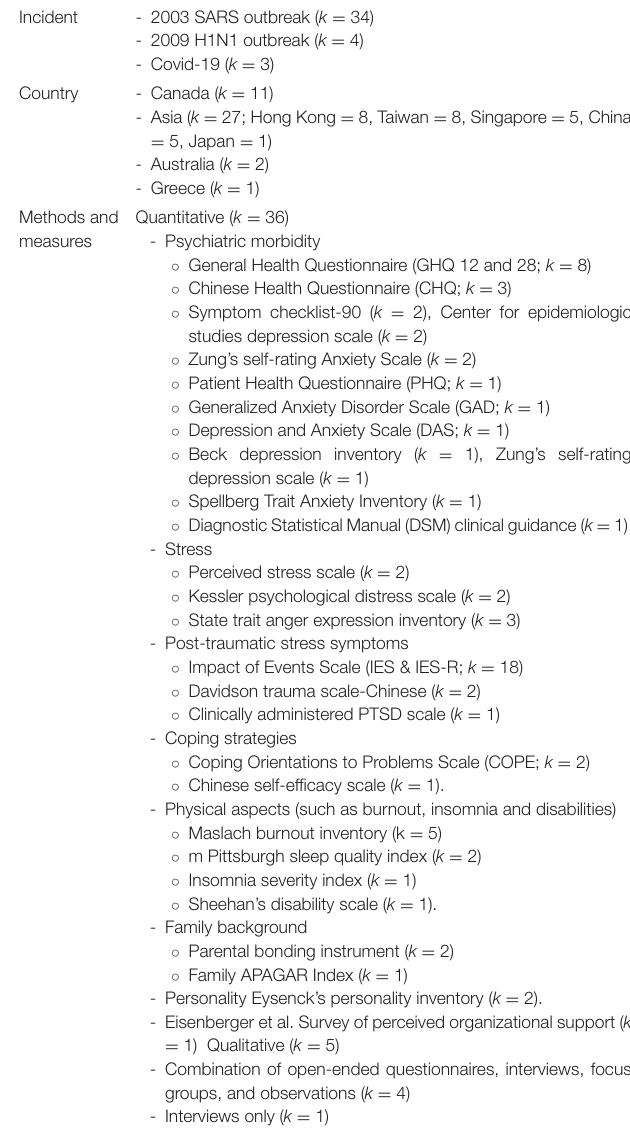
TABLE 2 | Composition of study population and data collection methods and measures used.